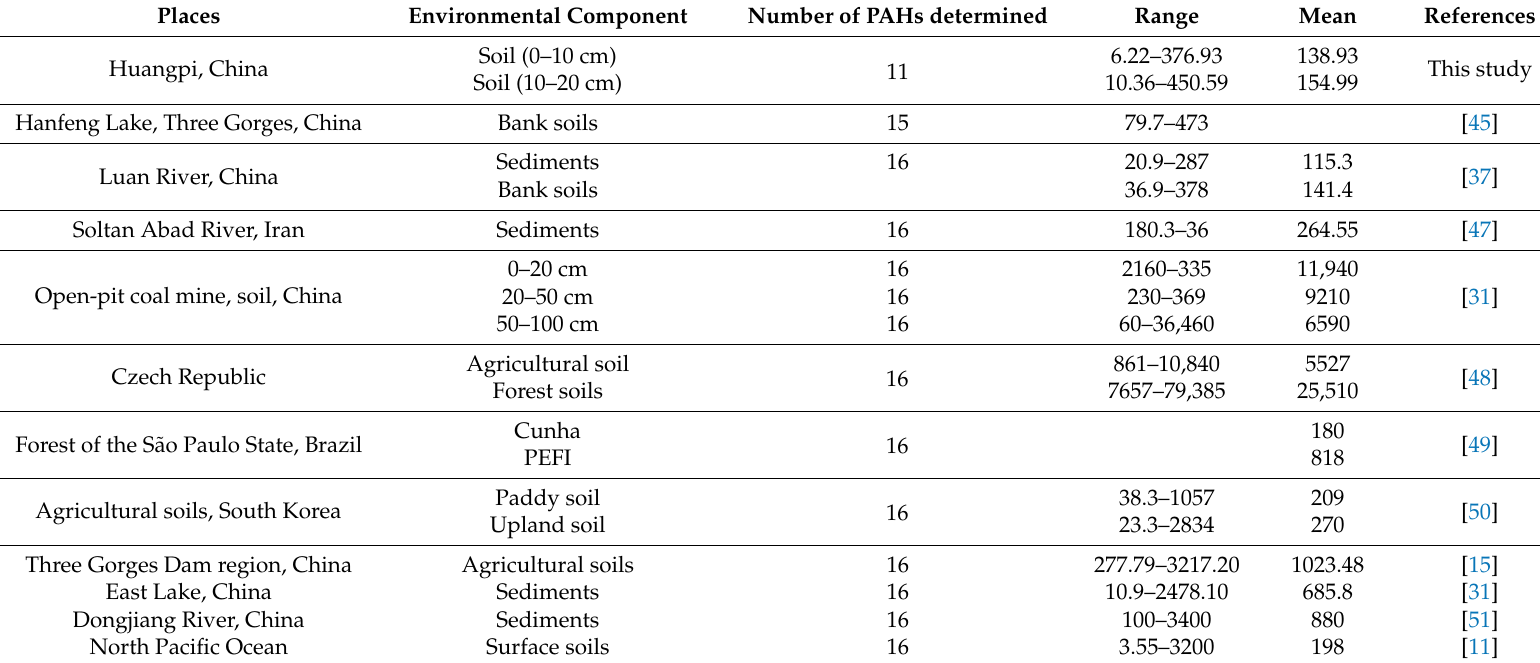
Table 4. Comparison of the concentrations of PAHs ( µ g kg − 1 ) with those obtained at other locations.